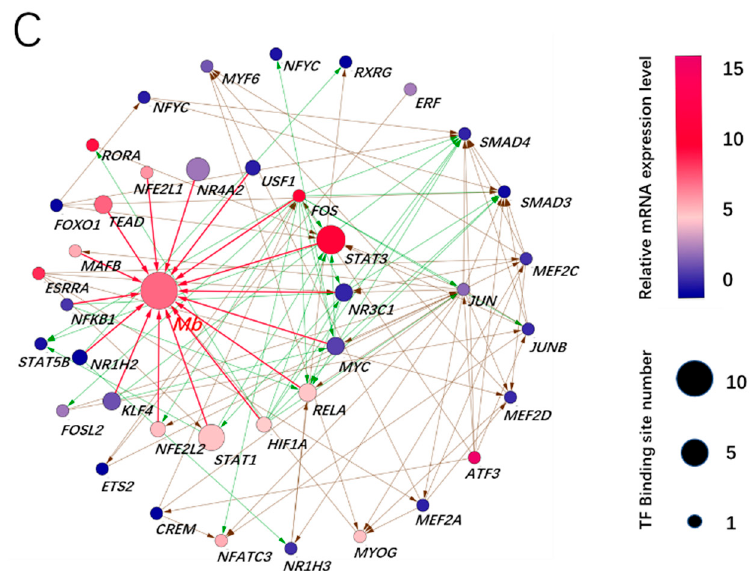
Figure 5. qRT-PCR validation of transcription factors on the porcine Mb gene regulatory network of the Bama breed. ( A ) core transcription factor expression of the Bama breed in the Mb-TFs network; ( B ) secondary transcription factor expression of the Bama breed in the Mb-TFs network; ( C ) overview of transcription factor expression foldchange and binding sites number of the Bama breed in the Mb ‐ TFs network. * p < 0.05, ** p < 0.01, *** p < 0.001, **** p < 0.0001, ns: no significance.